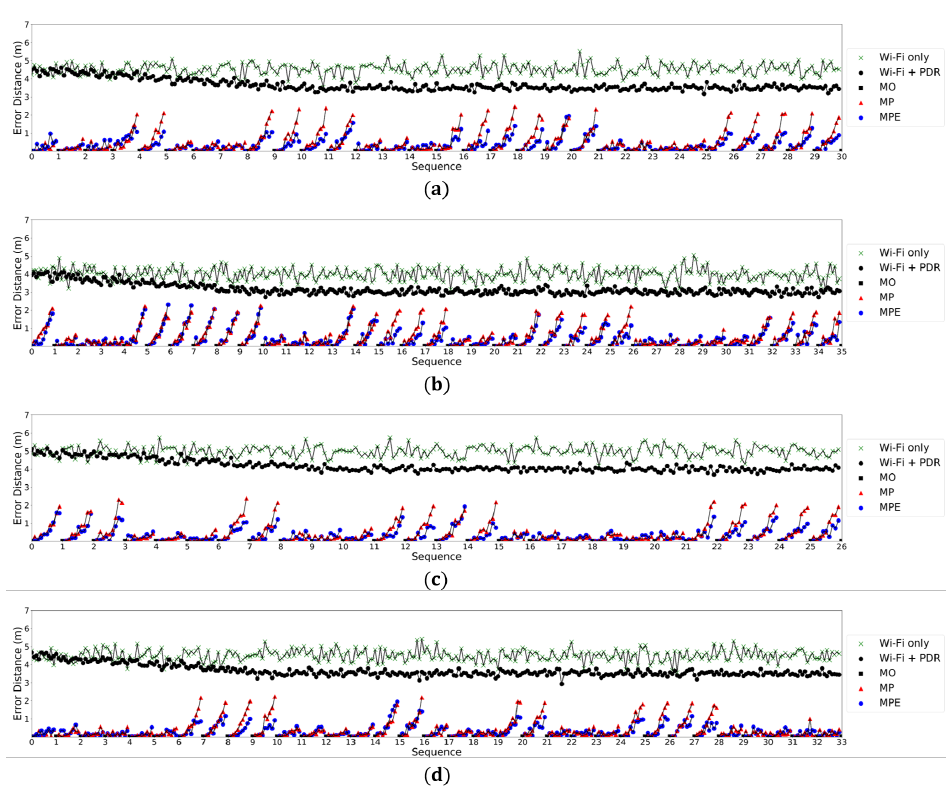
Figure 11. Tracking accuracy test of the HMIPS: ( a ) test path 1; ( b ) test path 2; ( c ) test path 3; ( d ) test path 4.